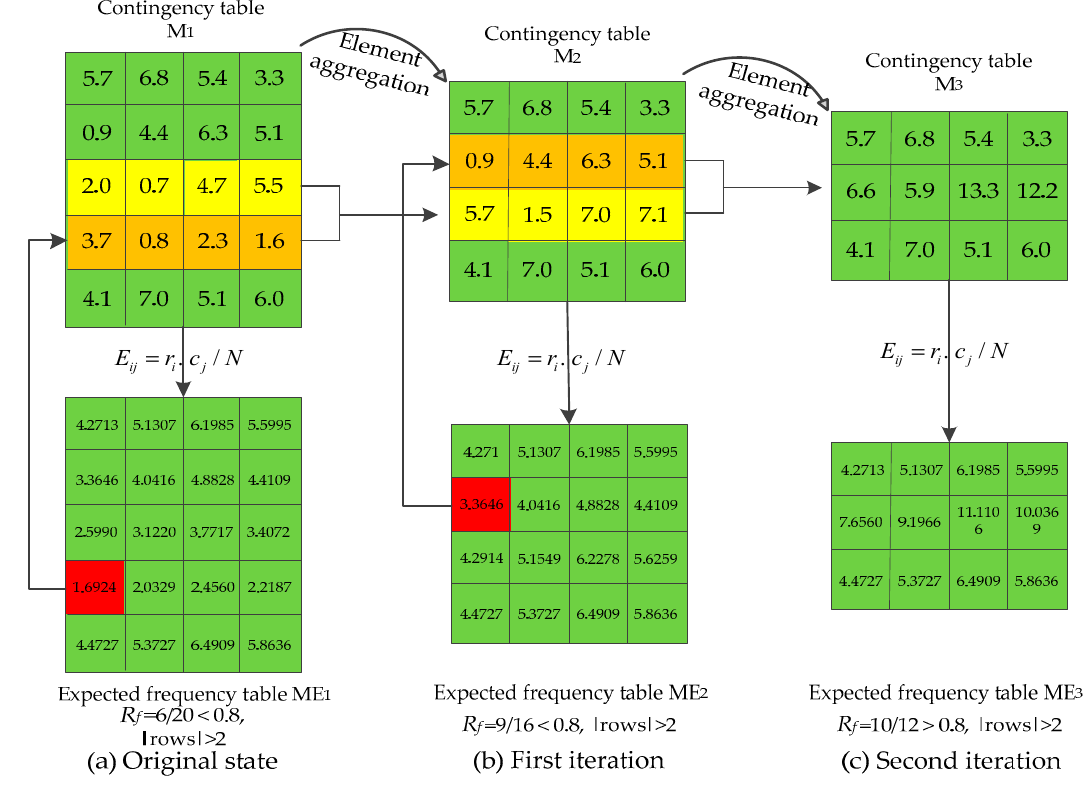
Figure 7. Case for recursive-element aggregation process.